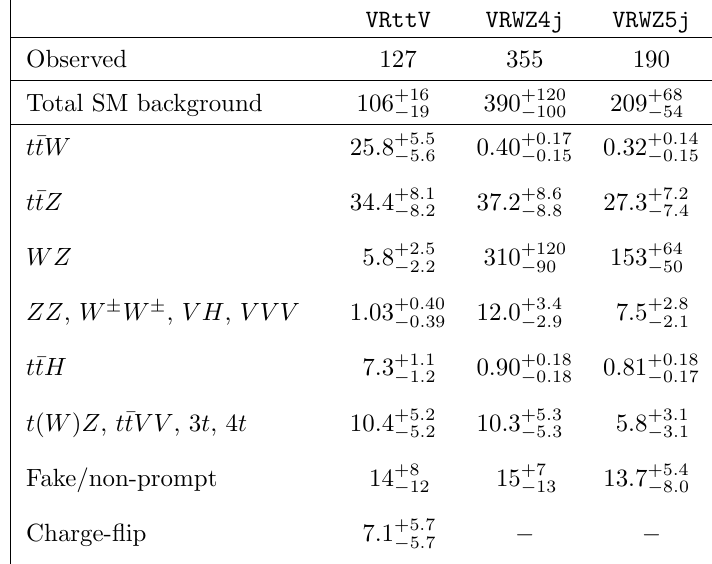
Table 4. Observed yields in data compared with the expected contributions from relevant SM pro- cesses (section 5) and the reducible background (section 6), in the three VRs enriched in WZ +jets and t (cid:22) tV processes. The displayed numbers include all sources of statistical and systematic uncer- tainties; since some of the latter might be correlated between di(cid:11)erent processes, the numbers do not necessarily add up in quadrature to the uncertainty in the total expected background. Selections with three leptons are not a(cid:11)ected by the charge-(cid:13)ip electron background, so such contributions are denoted by (cid:0)